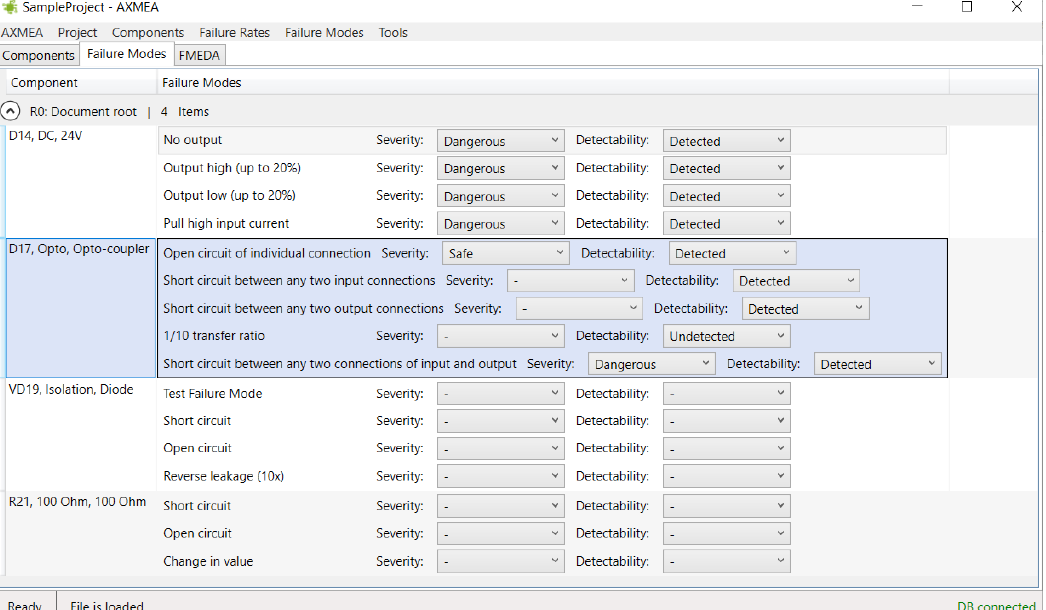
Figure 8. AXMEA tool: specification of severity and detectability.